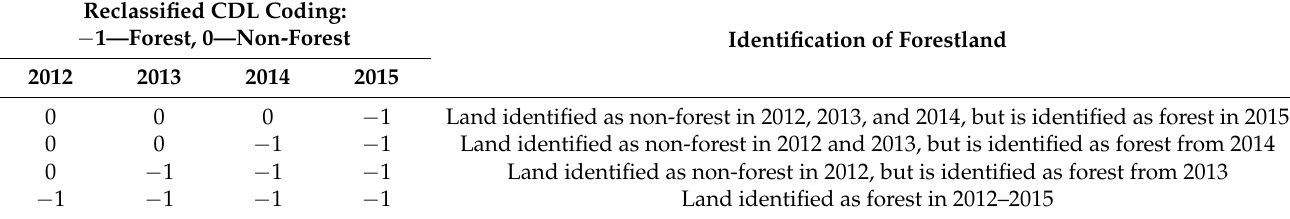
Table 2. Tracing the land identified as forest in the 2011 NLCD, but identified as non-forest in the 2011 CDL using the subsequent year’s CDL data.